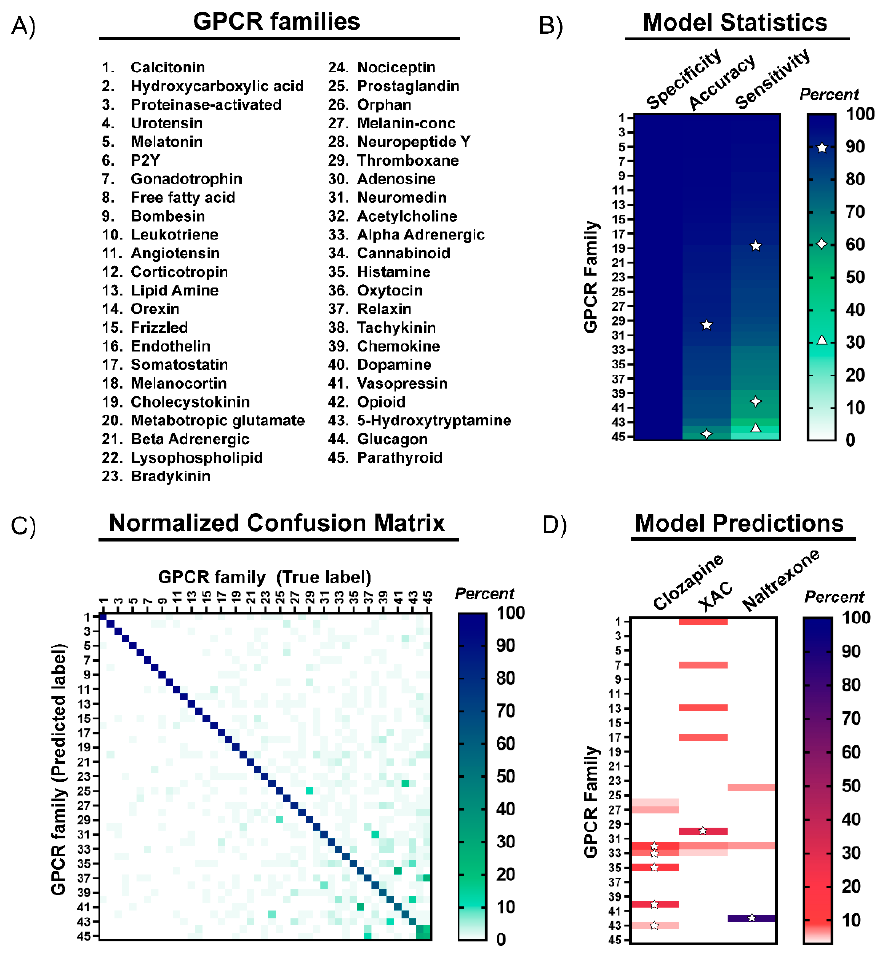
Figure 2. Metrics for machine learning model performance and example predictions. ( A ) GPCR families associated with the numbering scheme used in the figure. ( B ) Accuracy, sensitivity, and specificity metrics (%) of model predictions for compounds in the test dataset were calculated for each family and shown as a heatmap. Indicators of specific values in the legend for 30%, 60%, 90% (triangle, diamond, and star, respectively) are shown within each heatmap as a visual reference. ( C ) Confusion matrix comparing classification of compounds in the test dataset into their predicted versus true (annotated) GPCR target family. The value at each position in the heatmap represent the percentage of compounds in the test set classified into each GPCR family. ( D ) Example of model predictions for three unmodified molecular scaffolds. Model predictions are shown as a heatmap specifying the classification probability (%) for each GPCR family. Stars are used to mark predictions of known GPCR family interactions. Numerical values for all heatmaps are included as tables in Figures